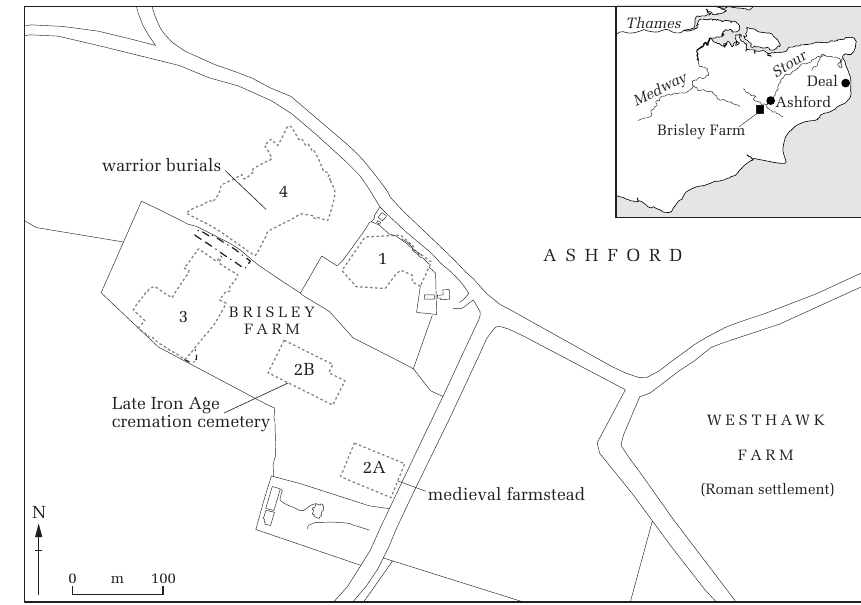
Figure 1 The location of the Brisley Farm site in Kent, showing the positions of the four areas of excavation (1–4) and the nearby Roman settlement at Westhawk